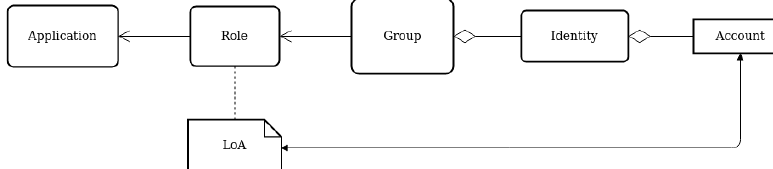
Figure 4. Authorization model